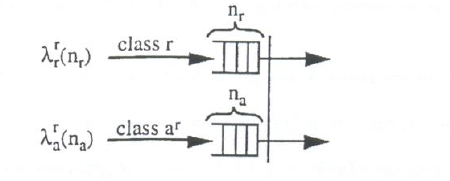
Figure 6. An aggregated synchronization station.